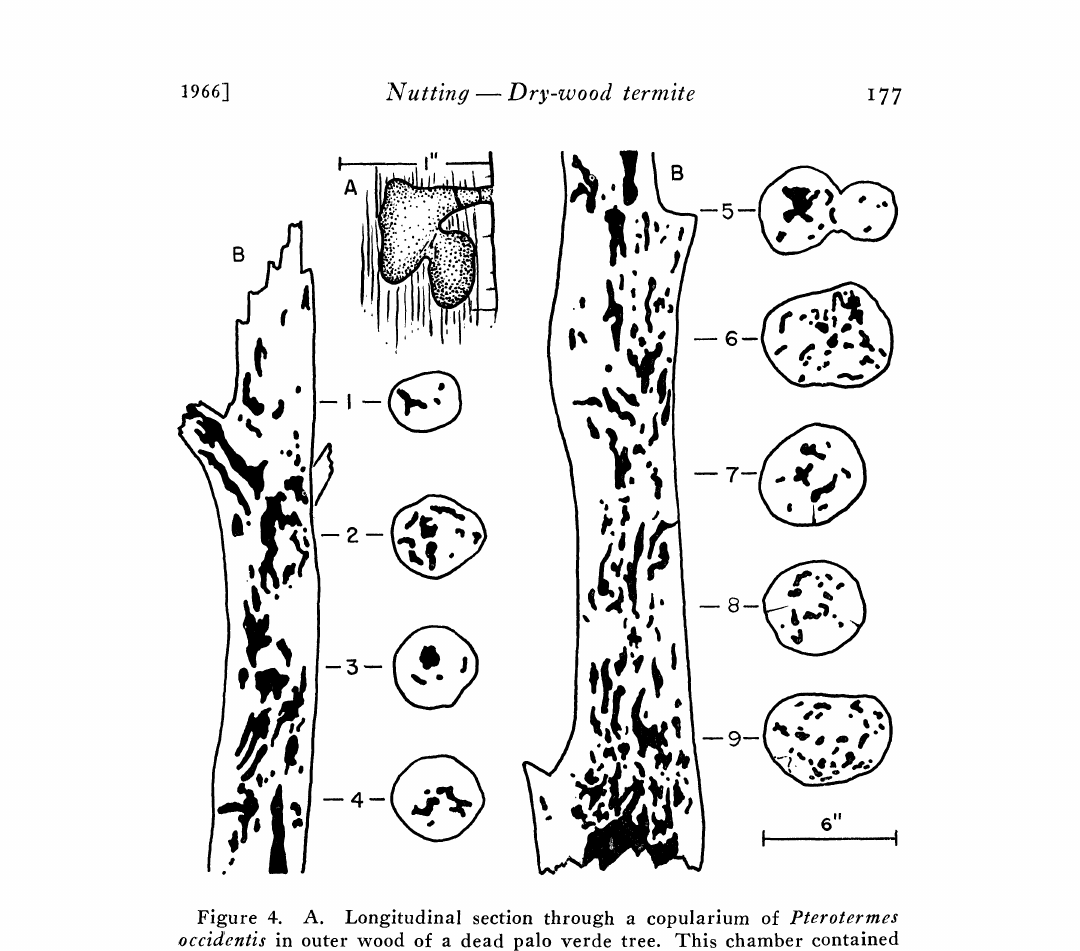
Figure 4. A. Longitudinal section through a eopularium of Pterotermes occidentis in outer wood of a dead palo verde tree. This chamber contained a primary pair and four small nymphs. B. Longitudinal section showing the galleries of Pterotermes in a dead palo verde from the vicinity of Oracle Jet., Arizona. Cross sections 1-9 represent tracings of the galleries in ad- acent